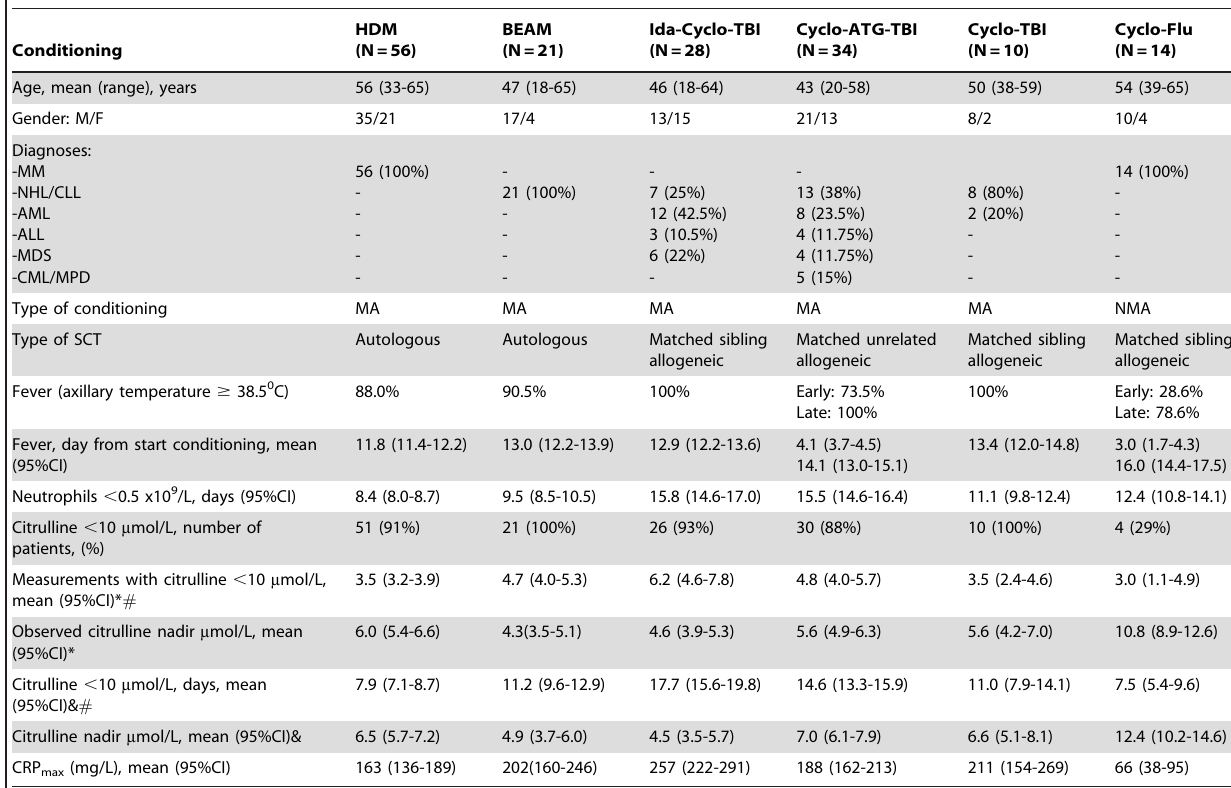
Table 2. General